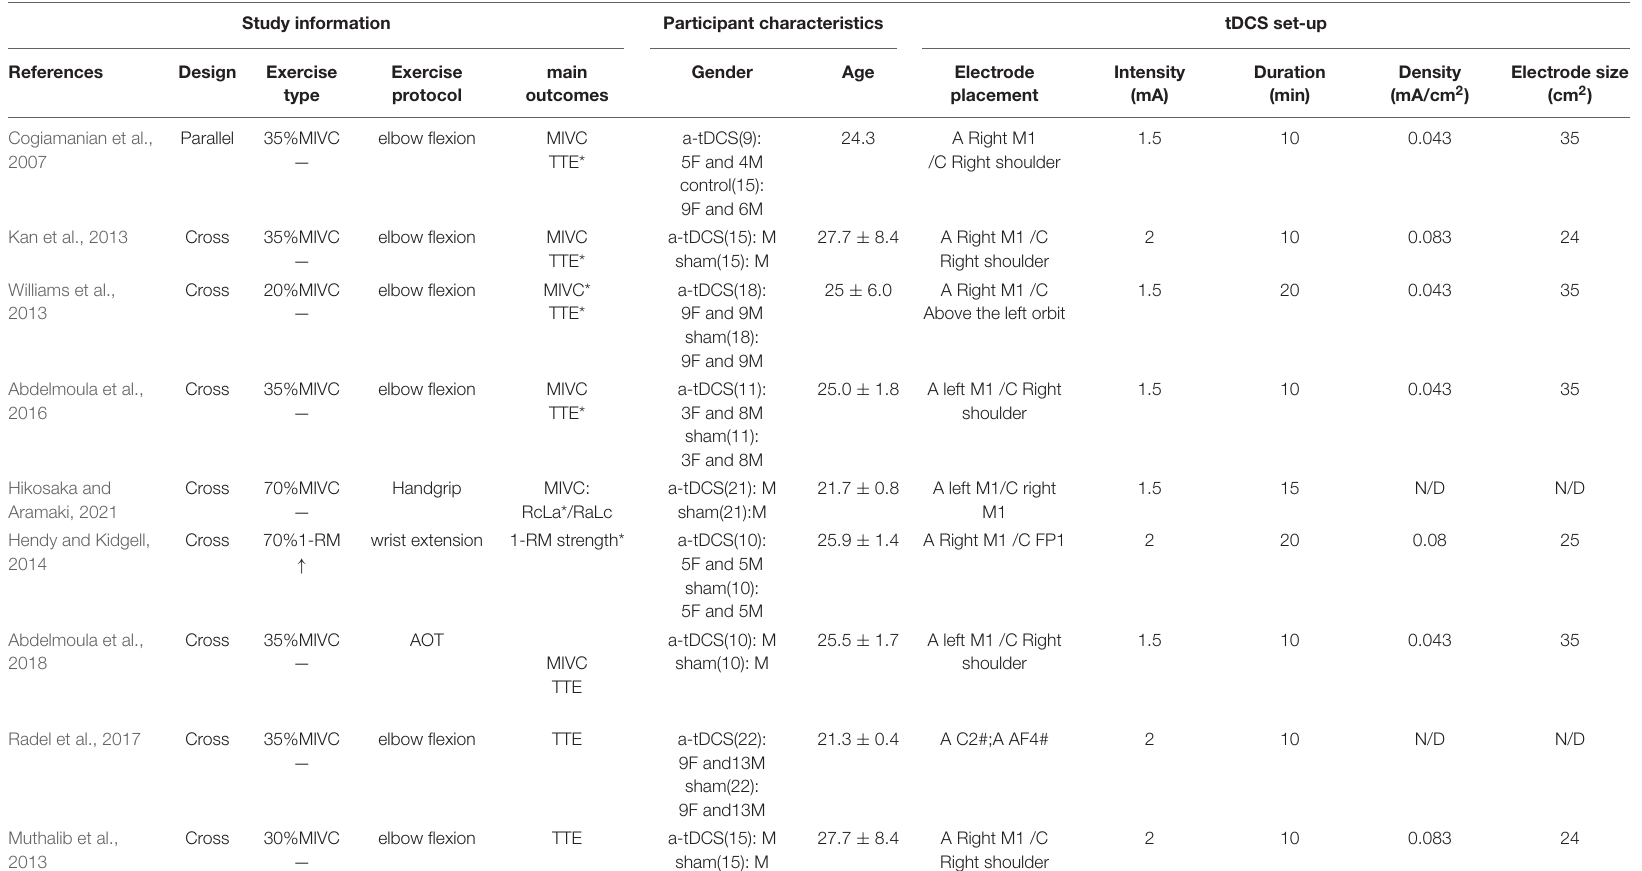
TABLE 1 | Characteristics of the included